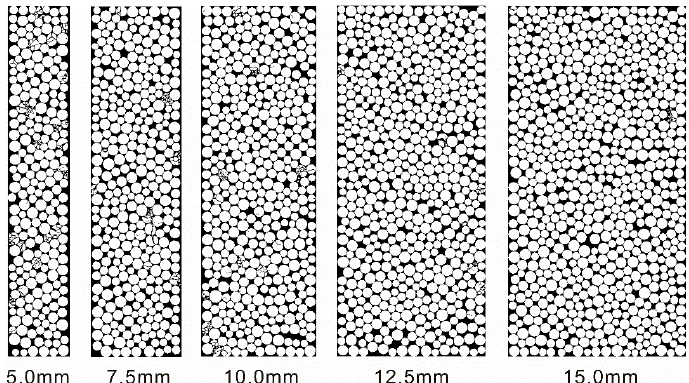
Figure 14. The configuration change of the filled joint with different thicknesses after loading by the stress waves.